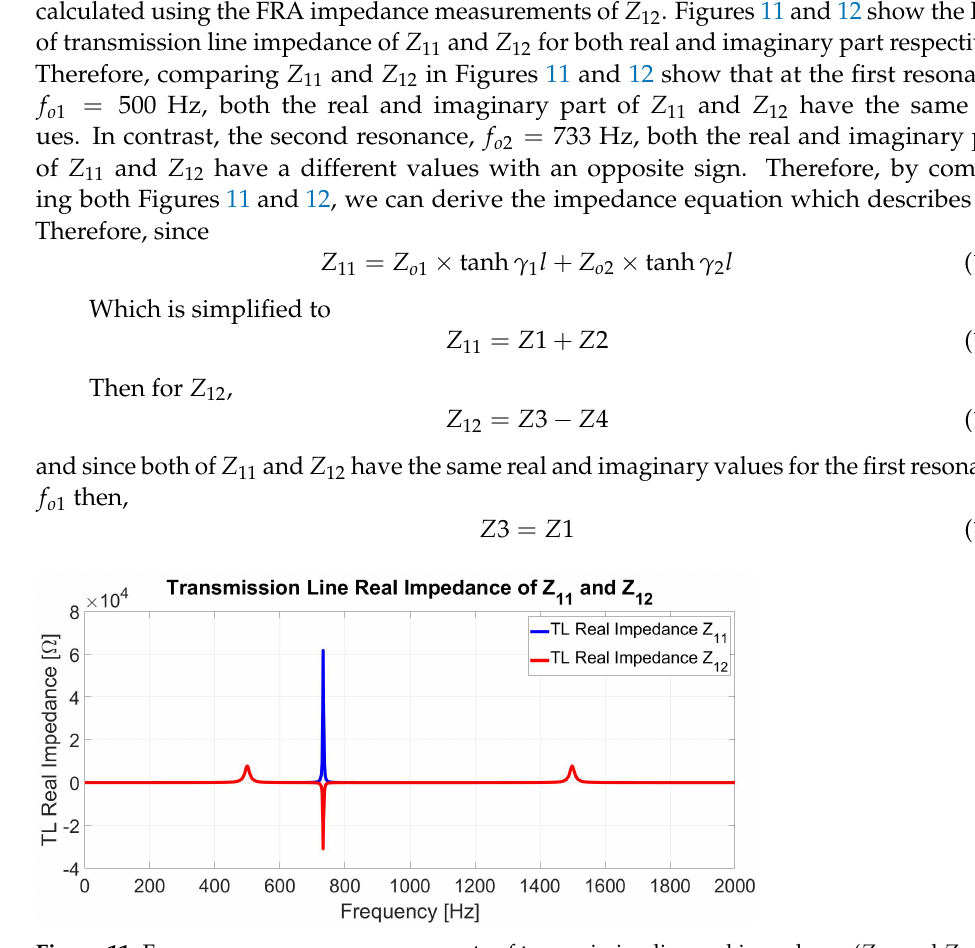
Figure 11. Frequency response measurements of transmission line real impedance ( Z 11 and Z 12 ).